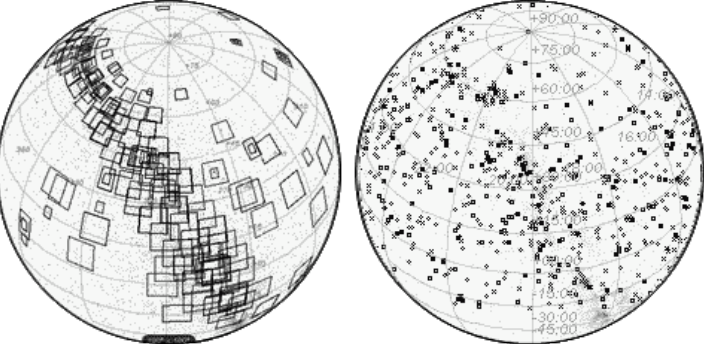
Fig. 3. The distribution on the celestial sphere of spectroscopic plates taken using the astrographs with objective prisms (left panel) and with the 1-m (crosses), 1.22-m (diamonds), 2.6-m (squares) telescopes (right